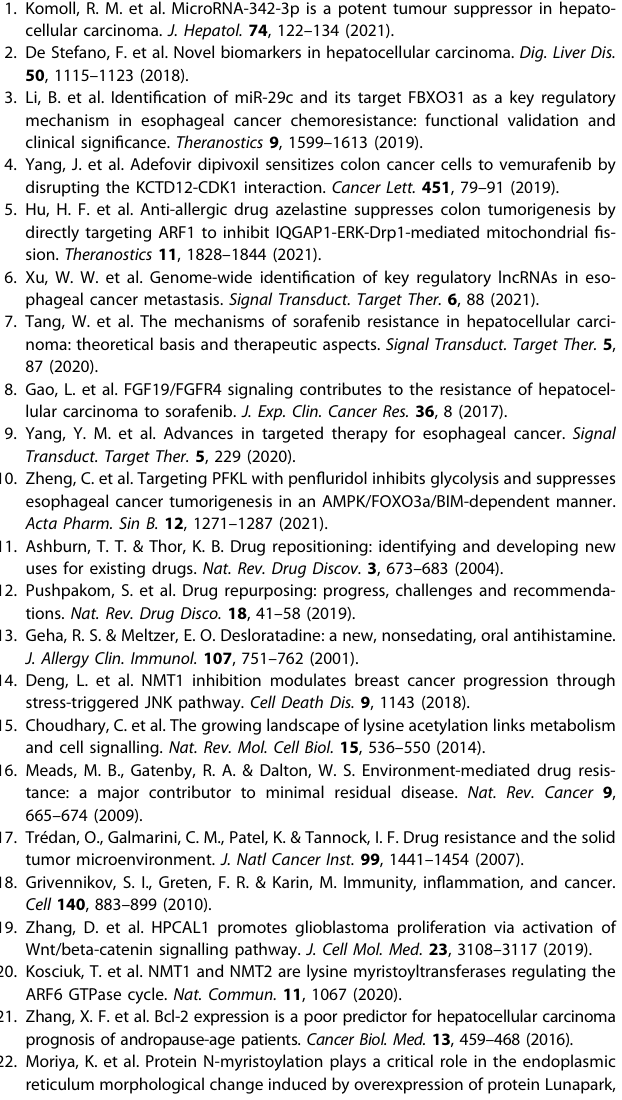
Fig. 6 Desloratadine suppresses HCC tumorigenesis in PDO and PDX models. a Organoids (PDO#1 and PDO#2) were treated with different concentrations of desloratadine or vehicle (DMSO) for 96 h, and cell viability was evaluated by a CellTiter-Glo Luminescent Cell Viability Assay. b The effect of desloratadine on organoid morphology was monitored. c Representative images showing the tumor growth curves of mice bearing established PDXs. Mice were fed 100 µl of desloratadine suspension (10 mg/kg or 20 mg/kg body weight) once every fi ve days or an equal volume of vehicle ( n = 5 per group). d Detection of NMT1 protein expression in HCC tissues from three patients by immunohistochemistry. e Analysis of the mRNA expression level of NMT1 in HCC tissues from three patients by qRT-PCR. f Ki67 staining in tumor tissue sections. g Western blot analysis showing the expression of NMT1, VILIP3, and NF κ B signaling pathway-related proteins in the xenograft tumors. h Schematic diagram summarizing how desloratadine suppresses NMT1 enzymatic activity and tumorigenesis. Bars, SDs; * p < 0.05; ** p < 0.01, *** p < 0.001, and n.s., no signi fi